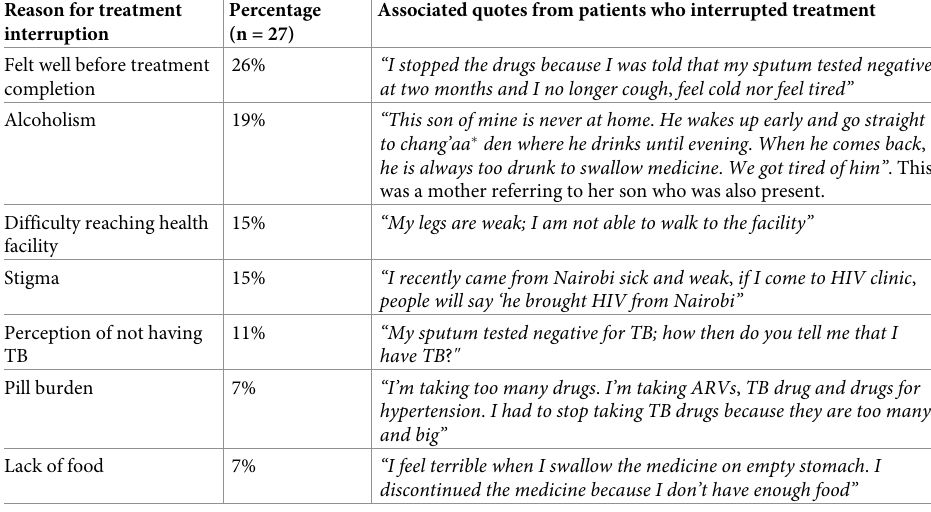
Table 4. Reasons the traced patients gave for interrupting TB